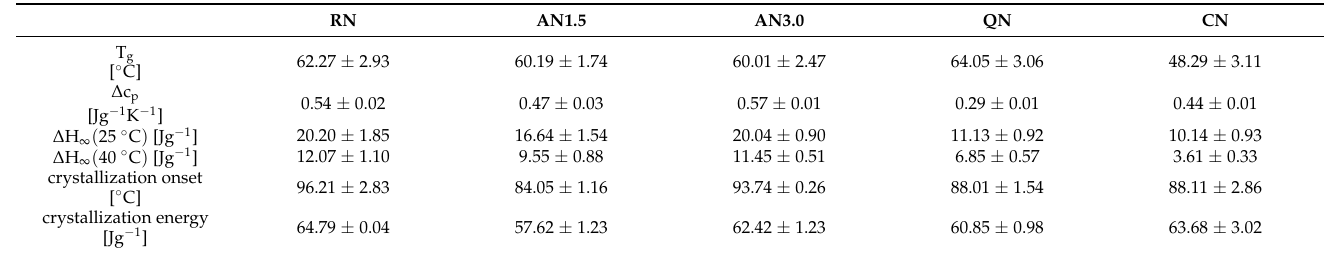
Table A3. Calorimetric data of the 2gl_1.6PS_Suc [ ◦ C]. n = 2, values represent the mean value and the corresponding standard deviation.